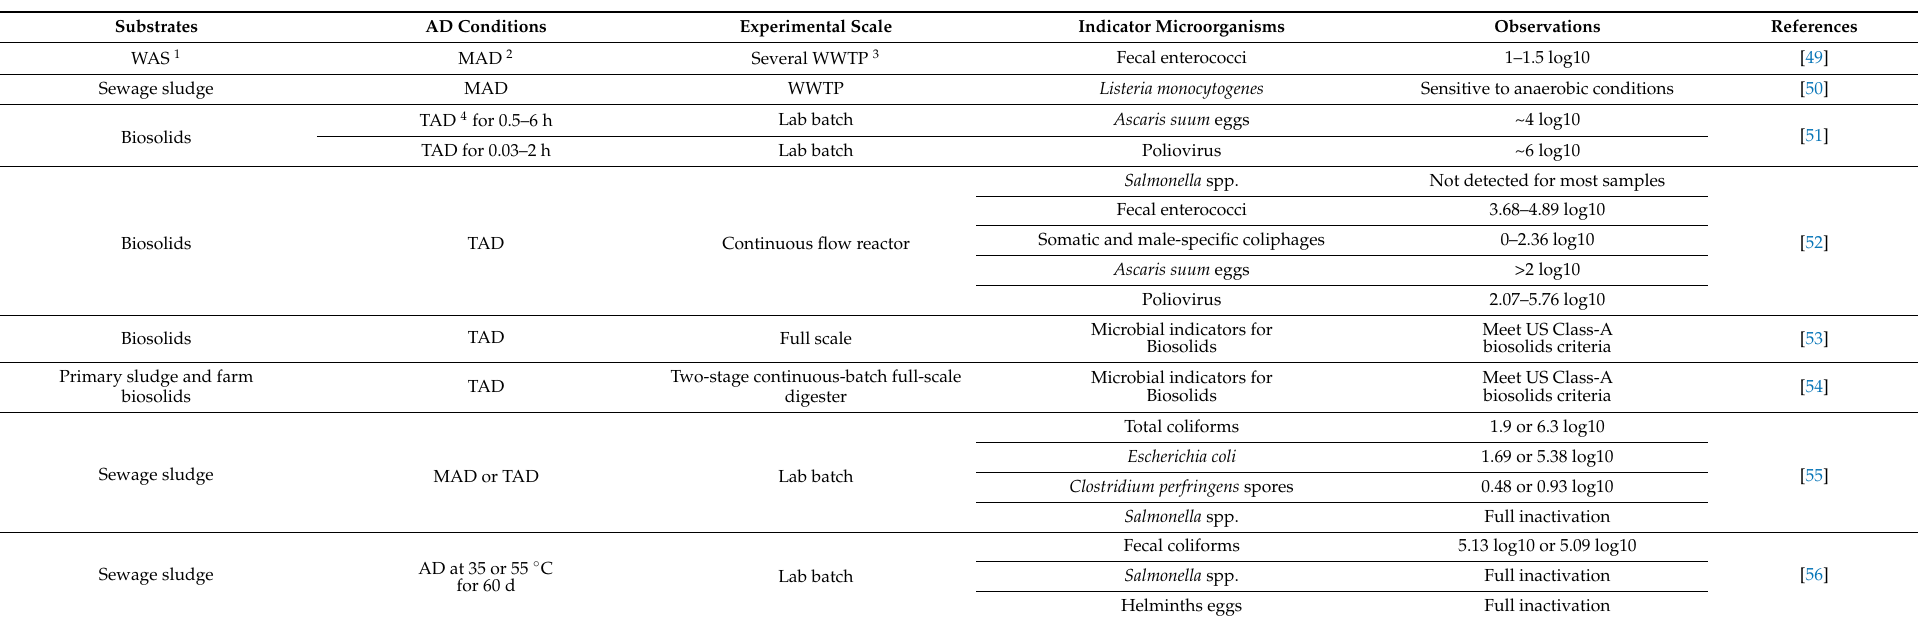
Table 4. Literature data about the efficiency of AD process on pathogens inactivation in sewage